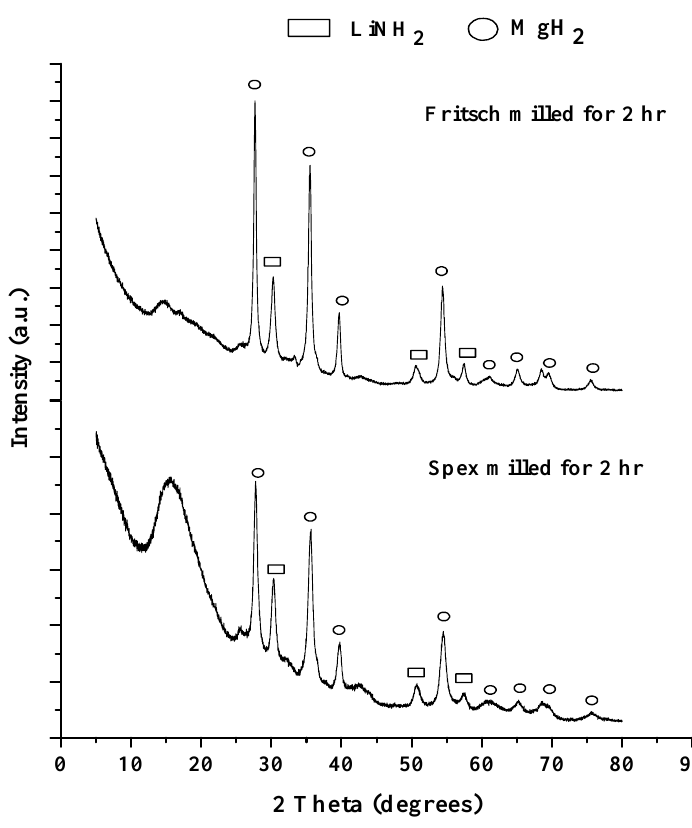
Figure 2. XRD pattern for the Fritsch milled (top) and Spex milled (bottom)